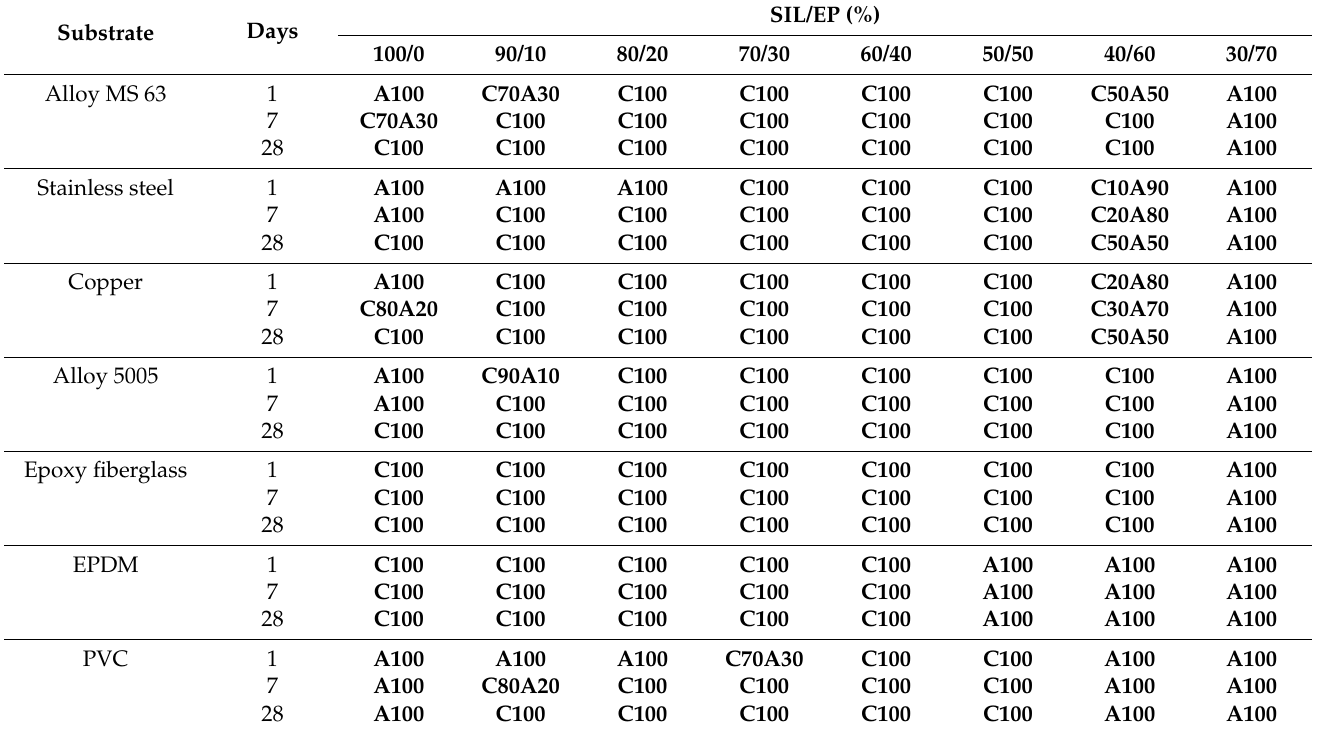
Table 4. Peel tests of two component SIL/EP completed system (C—cohesive, A—adhesive fracture failure).